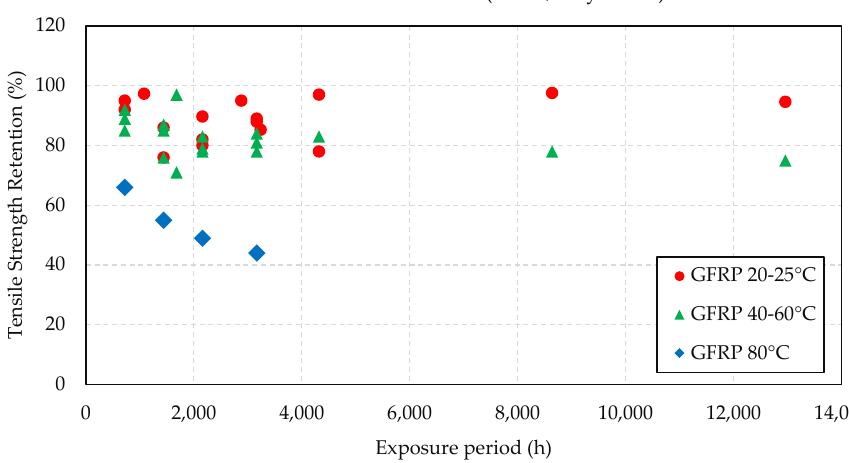
Figure 2. GFRP bars immersed in water solution from the available literature [55 – 59].